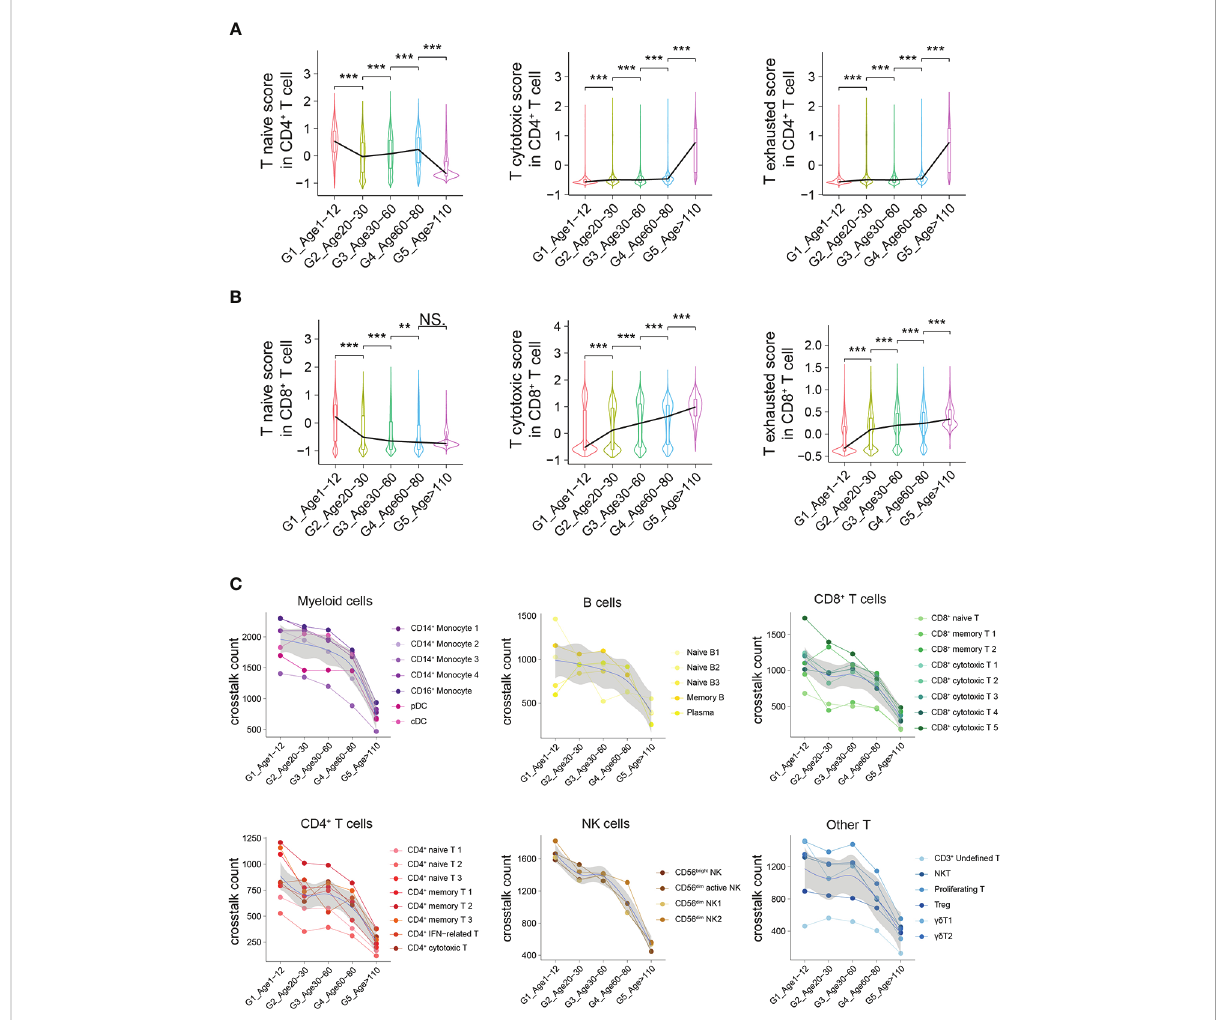
FIGURE 5 Active intercellular crosstalk of PBMCs in childhood. (A, B) Naive state, cytotoxicity and exhaustion scores of different CD4 + T cells (A) and CD8 + T cells across 5 groups. All differences with P <0.01 are indicated. NS, not statistically signi fi cant; ** P <0.001; *** P <0.0001. (C) The intercellular crosstalk number of each main cell type estimated using Cellphone DB, including myeloid cells, B cells, CD8 + T cells, CD4 + T cells, NK cells and other T